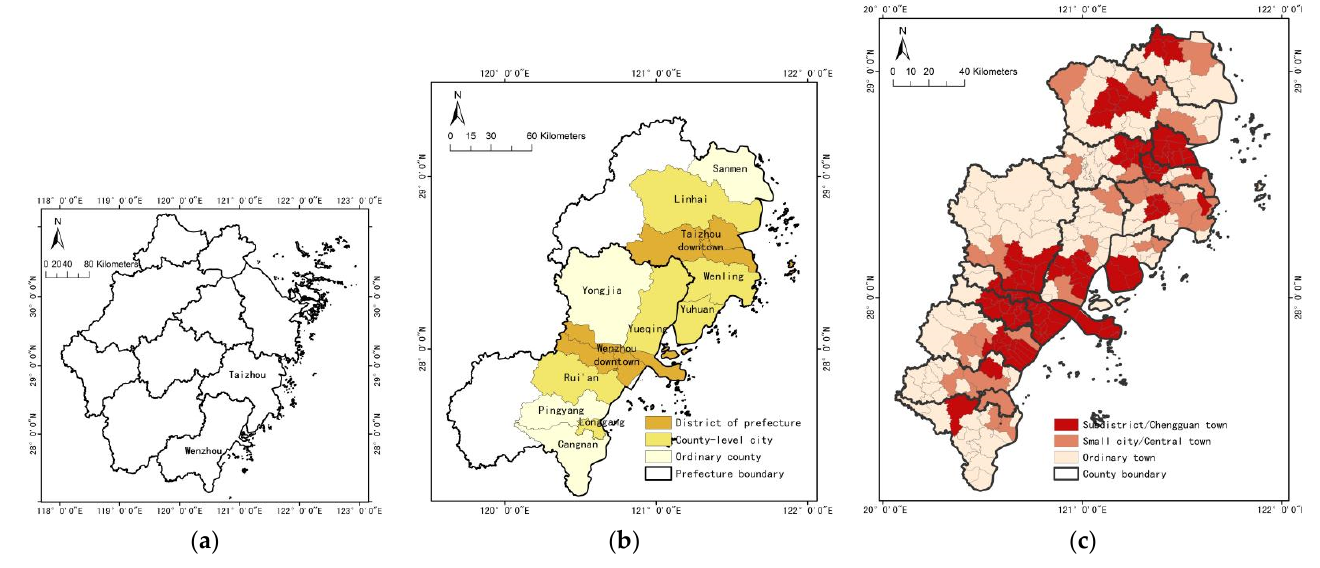
Figure 1. Different levels of the Wen-Tai region: ( a ) prefecture, ( b ) county, and ( c ) town.